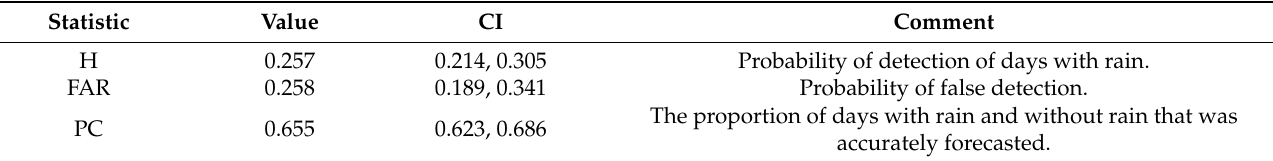
Table 8. The results of the calculated statistics are based on the results of the contingency table (Table 7). CI is the confidence interval for the H, FAR, and PC statistics. [ 0 ≤ H ≤ 1 ] , [ 0 ≤ FAR ≤ 1 ] , and [ 0 ≤ PC ≤ 1 ] .